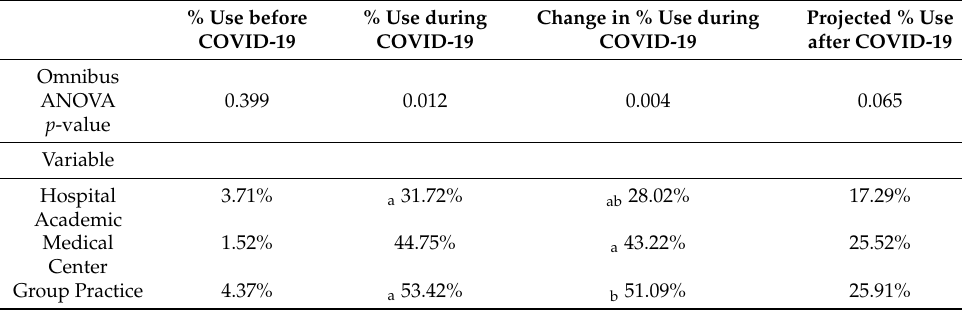
Table 2. Percentage use of telemedicine by primary practice